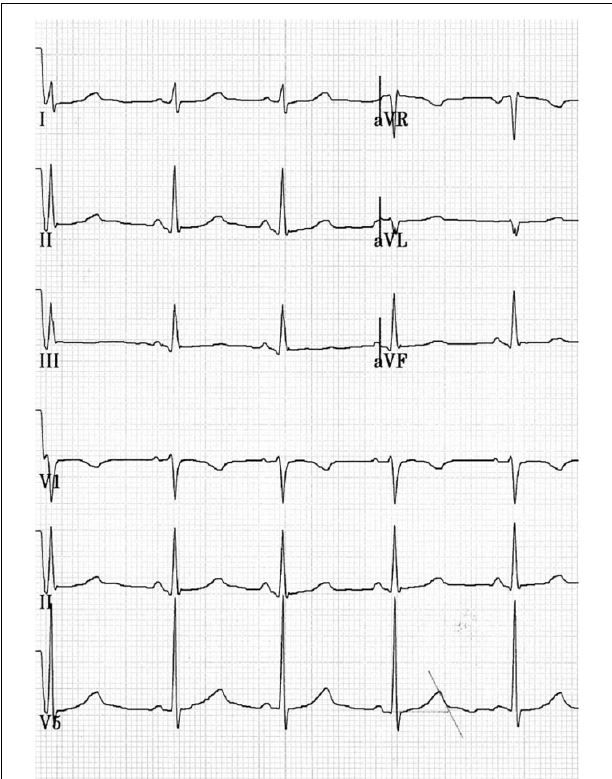
FIGURE 1 | Fragment of the resting ECG, 25 mm/s and 10.0 mm/mV. Female, 14 years old, competitive athlete (swimming). Sinus rhythm with HR 70 bpm, PR 128 ms, QRS 104 ms, and QTc 490–536